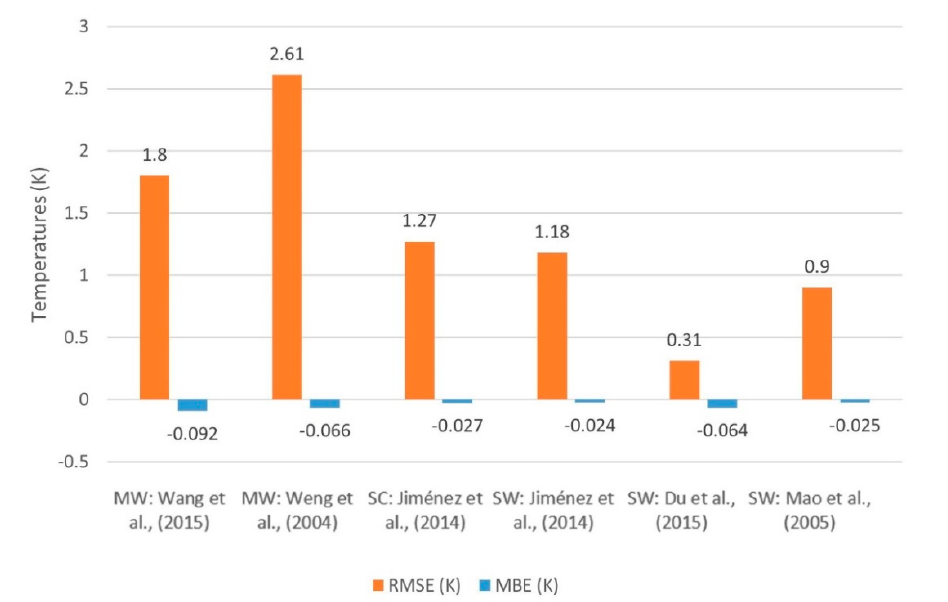
Figure 7. Linear fitting coefficients R 2 .